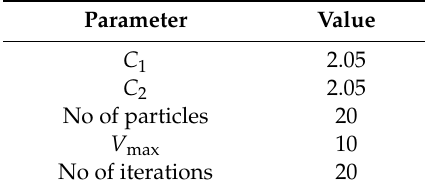
Table 2. Parameter settings of PSODV-Hop.